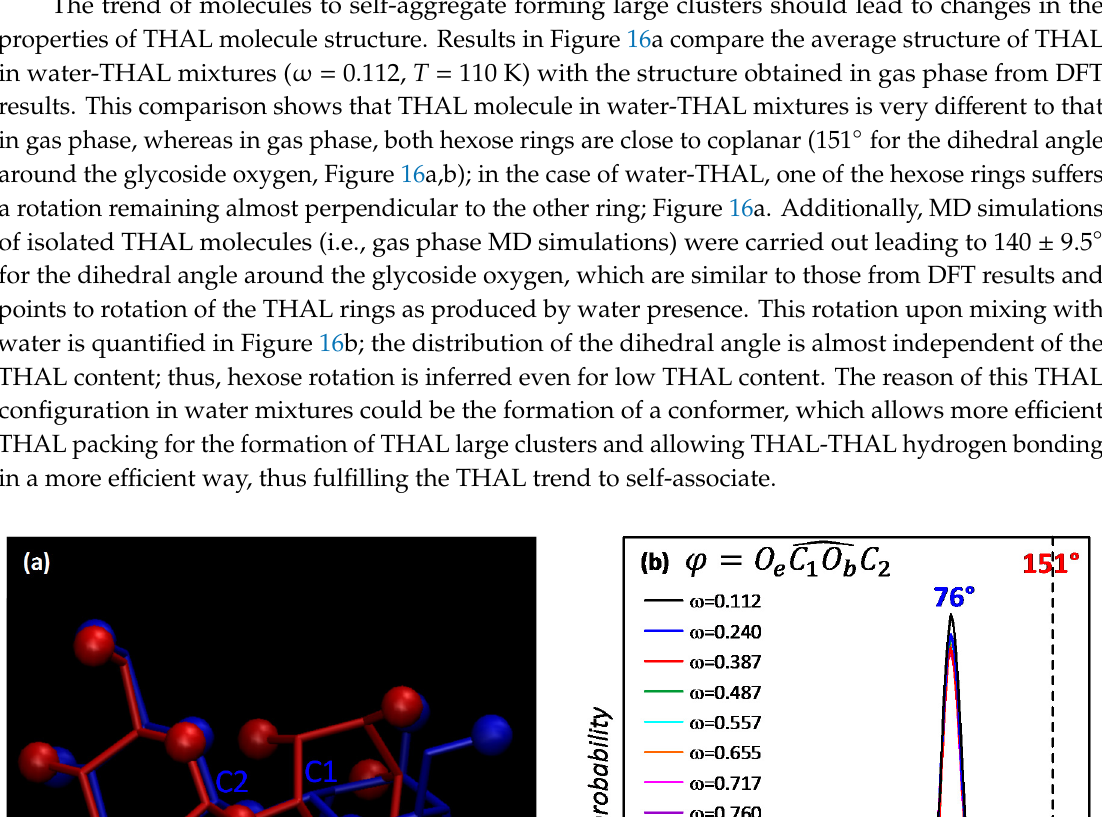
Figure 15. Kinetic parameters of hydrogen bonding for the reported interacting sites showing relaxation times, τ , for the ( a ) forward, i.e., hydrogen bond lifetime, and ( b ) backward, i.e., hydrogen bonding reformation after destruction, processes in ω THAL + (1- ω ) water mixtures ( ω = 0.112) as a function of temperature. Atom labels as in Figure 1. For THAL molecule, all available OH sites (O1 to O4, Figure 1) are considered as donor or acceptors.